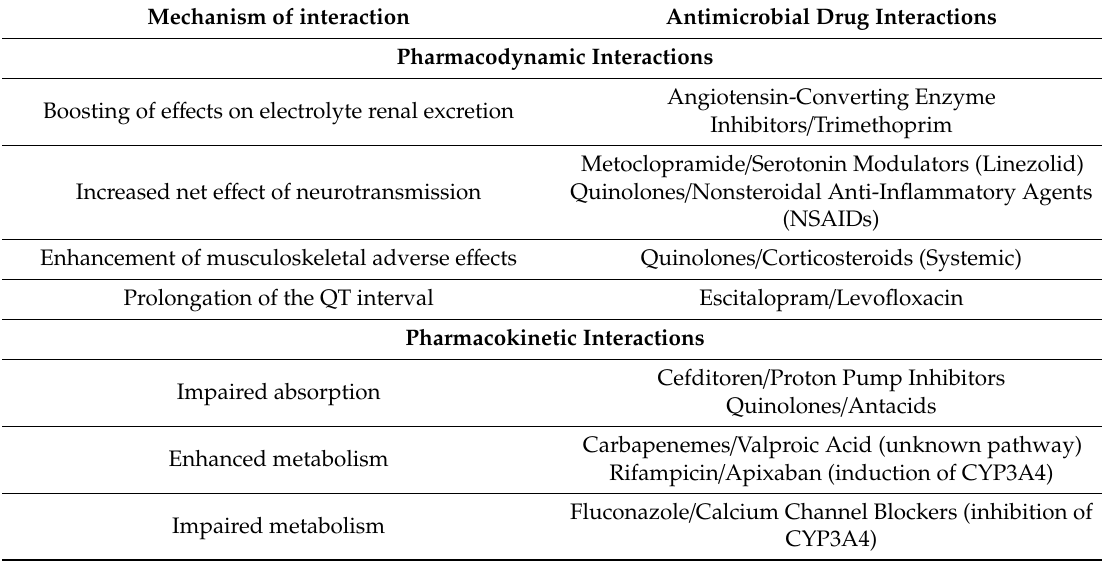
Table 1. Antimicrobial drug interactions selected to be